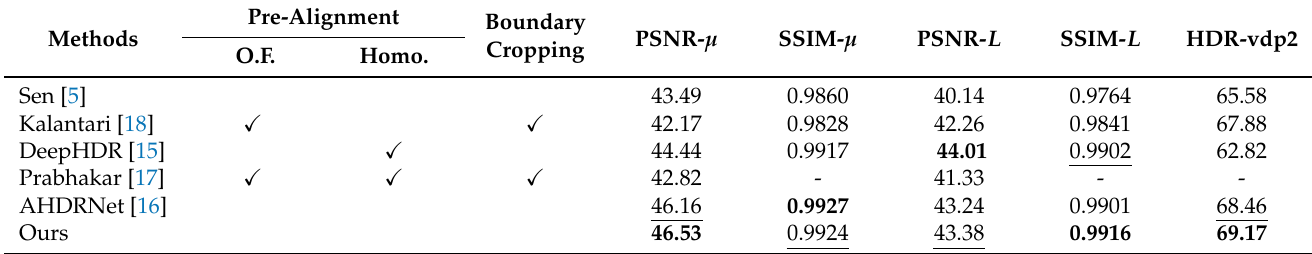
Table 2. Quantitative comparisons of our method with state-of-the-art methods on Kalantari dataset, with the best result in bold and the second-best result underlined. Here, O.F. and Homo. refer to the optical-flow-based alignment and the homographic transformation adopted by different methods, respectively.